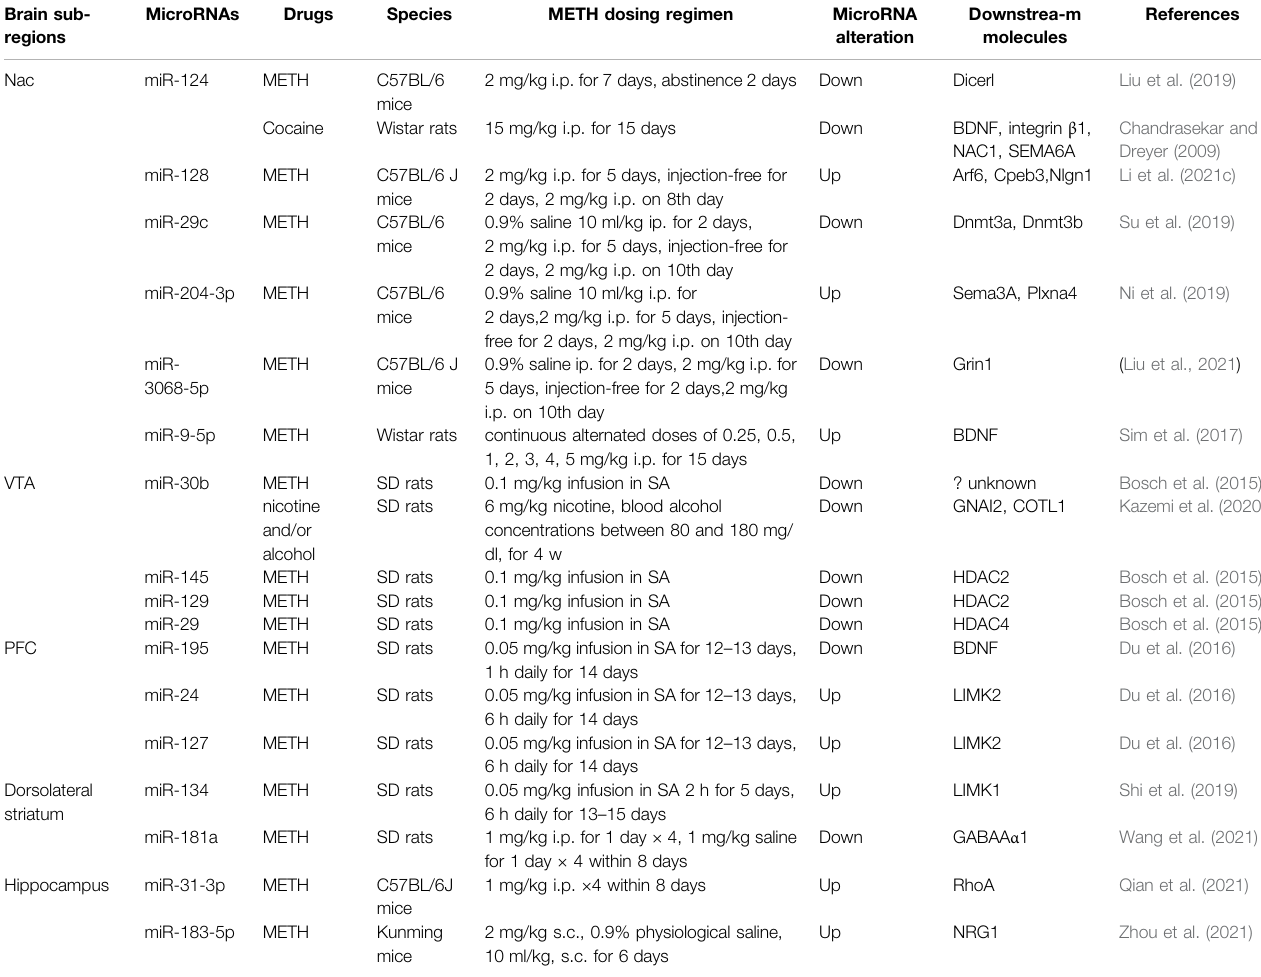
TABLE 2 | MiRNAs in METH addiction. Brain sub- regions